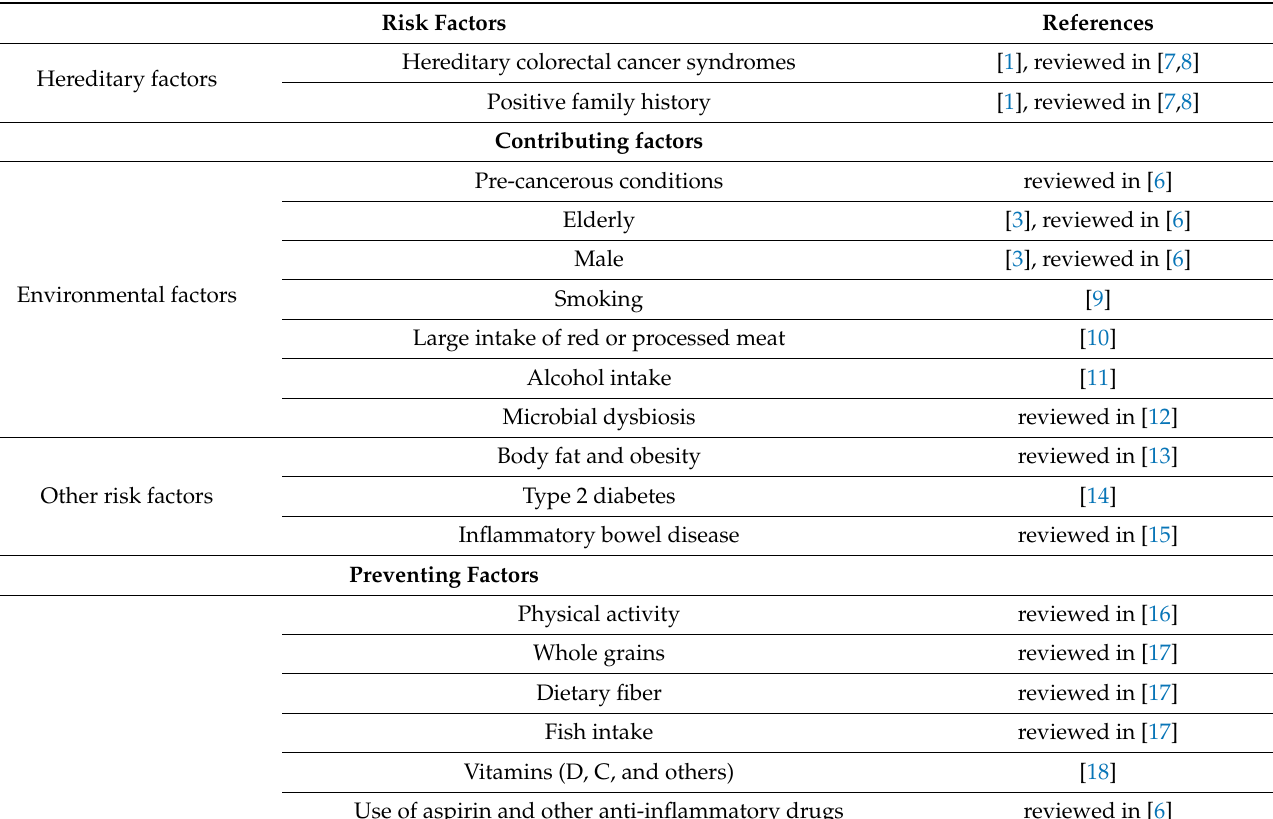
Table 1. Leading risk factors of colorectal